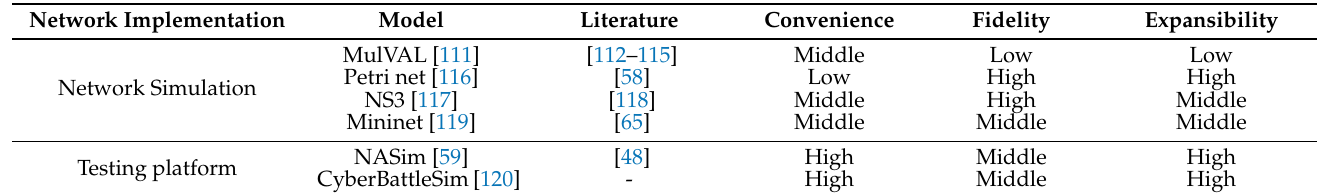
Table 3. Comparison of Current Network Training and Testing